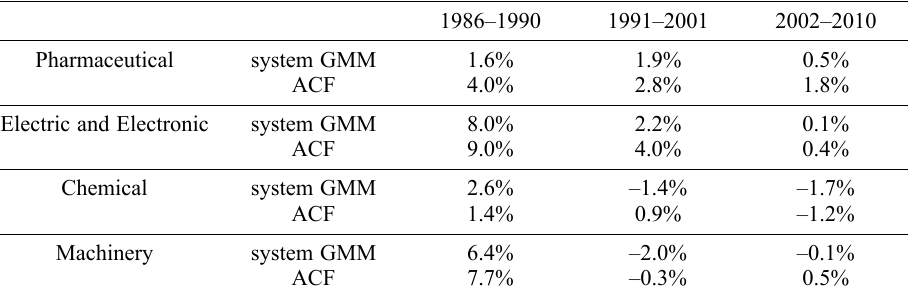
Table 8. Average growth of TFP by